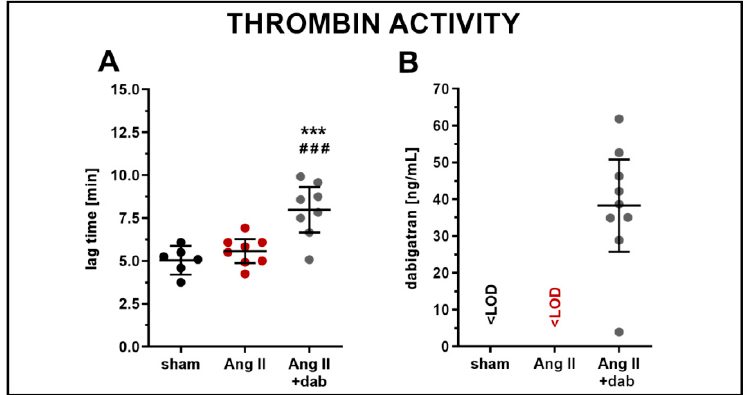
Figure 2. Effect of dabigatran on thrombin activity and its concentration in plasma in Ang II hypertensive mice. Thrombin activity expressed as lag time parameter ( A ; n = 6–8) and concentration of dabigatran in murine plasma ( B ; n = 9) were assessed in mice subjected to s.c. administration of Ang II (1 mg/kg b.w per day; 1 week) via micro-osmotic pumps. Data are shown as means (–) ± 95% CI (I) and considered statistically significant at *** p ≤ 0.001 and ### p ≤ 0.001 using Tukey’s post hoc test ( A ). * indicates statistical difference between sham mice and Ang II- or Ang II+ dab-treated animals; # indicates statistical difference between Ang II- and Ang II+ dab- treated mice.